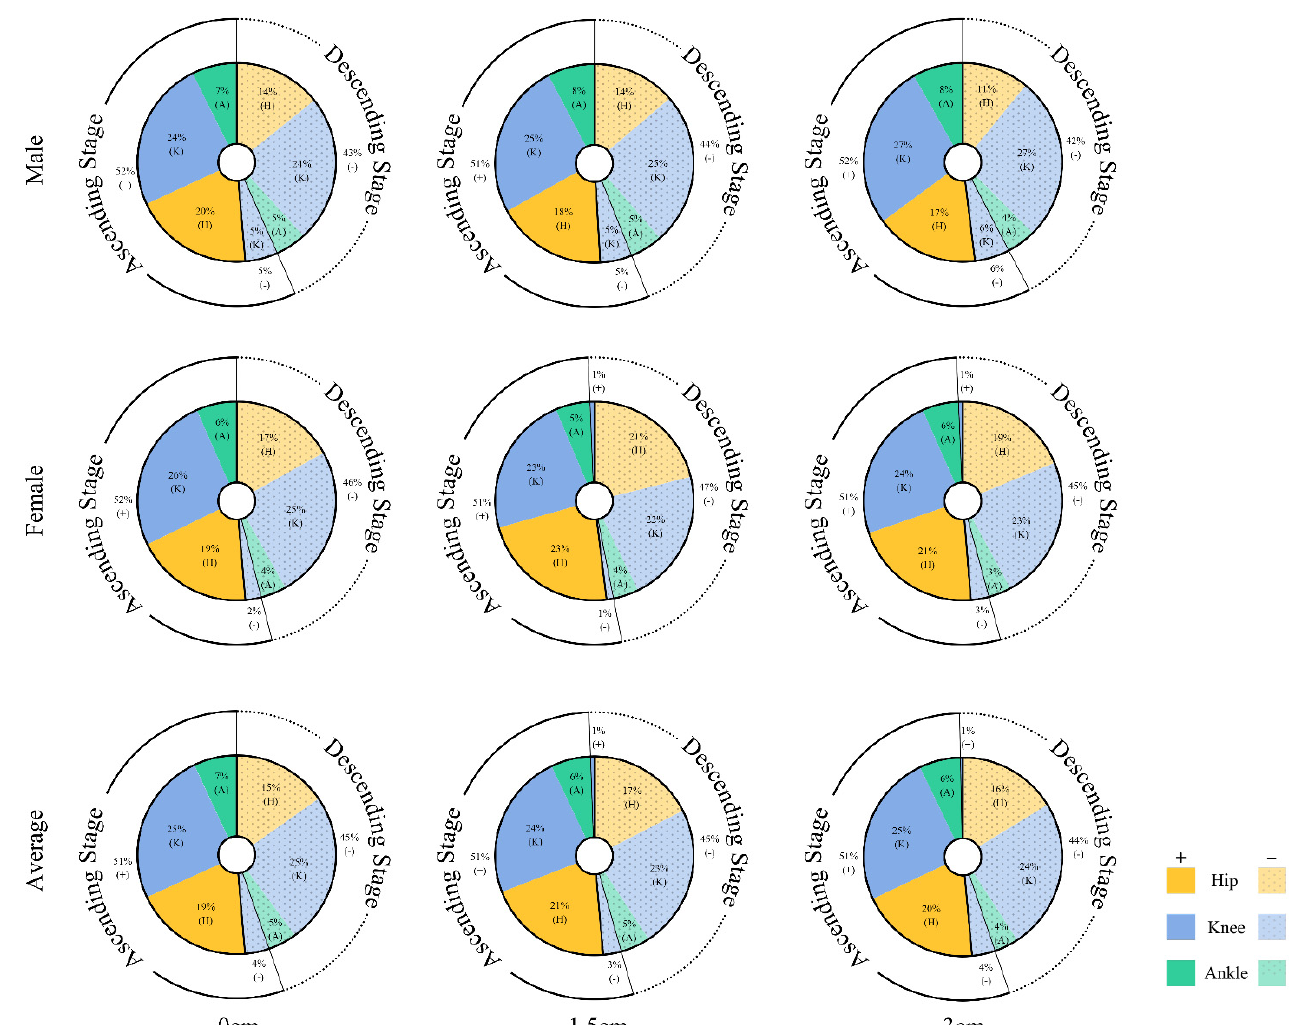
Figure 3. The percentage of work done by the hip, knee, and ankle joints during the descent and ascent of the barbell squat for different genders and heel heights. The percentage of work done by the joints was obtained by processing the joint power data.